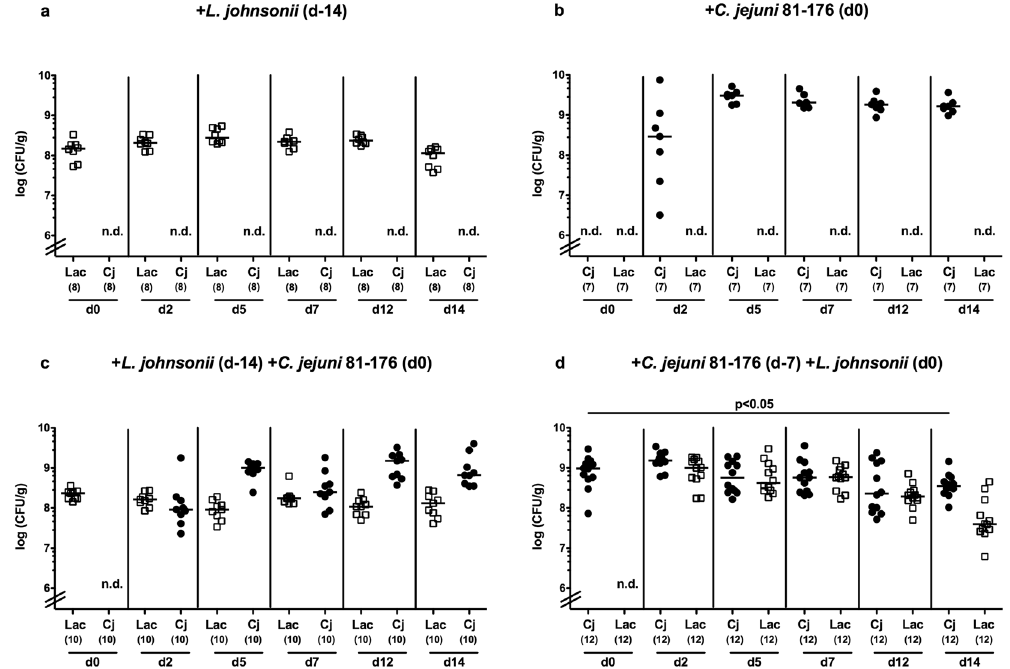
Figure 1. Kinetics of intestinal L . johnsonii and/or C . jejuni strain 81–176 loads in perorally reassociated secondary abiotic mice. Secondary abiotic mice were generated by broad-spectrum antibiotic treatment and perorally reassociated with ( a ) L . johnsonii (Lac; white squares) on day ( d ) − 14, ( b ) C . jejuni strain 81–176 (Cj; black circles) on d0, ( c ) L . johnsonii on day − 14 and C . jejuni strain 81–176 on d0, or ( d ) C . jejuni strain 81–176 (d-7) and L . johnsonii on d0 as described in methods. Bacterial colonization densities were assessed in fecal samples (CFU/g, colony forming units per gram) over time upon reassociation as indicated by culture. Medians (black bars) and levels of significance (p-value) determined by Mann-Whitney U test are indicated. Numbers of analyzed mice are given in parentheses. Data were pooled from three independent experiments. N.d.: not